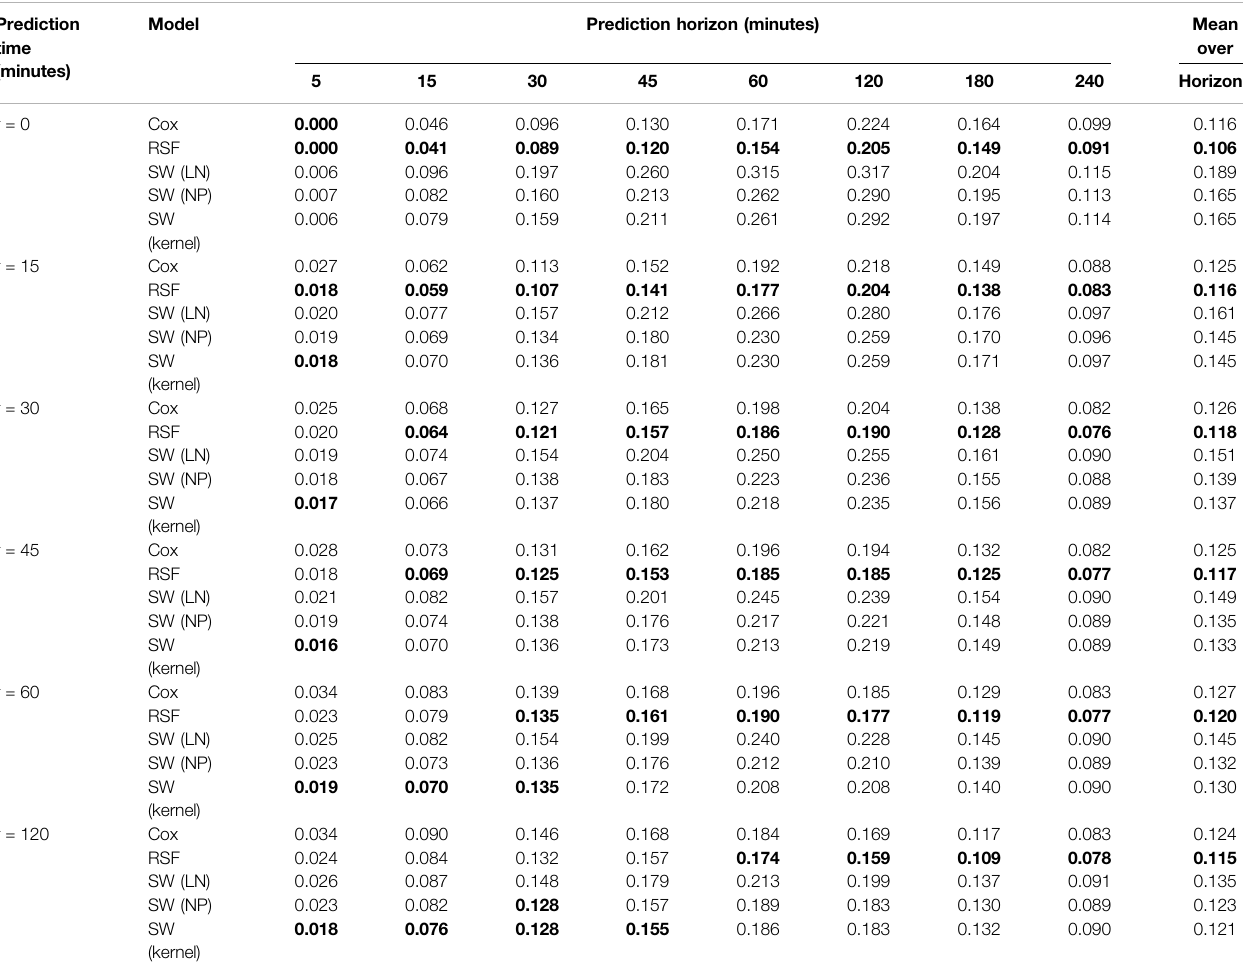
TABLE 4 | Brier scores for considered models, across a range of different prediction times (when predications are made) and prediction horizons (at what time after the prediction time they are evaluated). Lower values indicate a better model. Optimal values foreach prediction time -prediction horizon pair are shown in bold.All keys are as de fi ned in Table 3 .